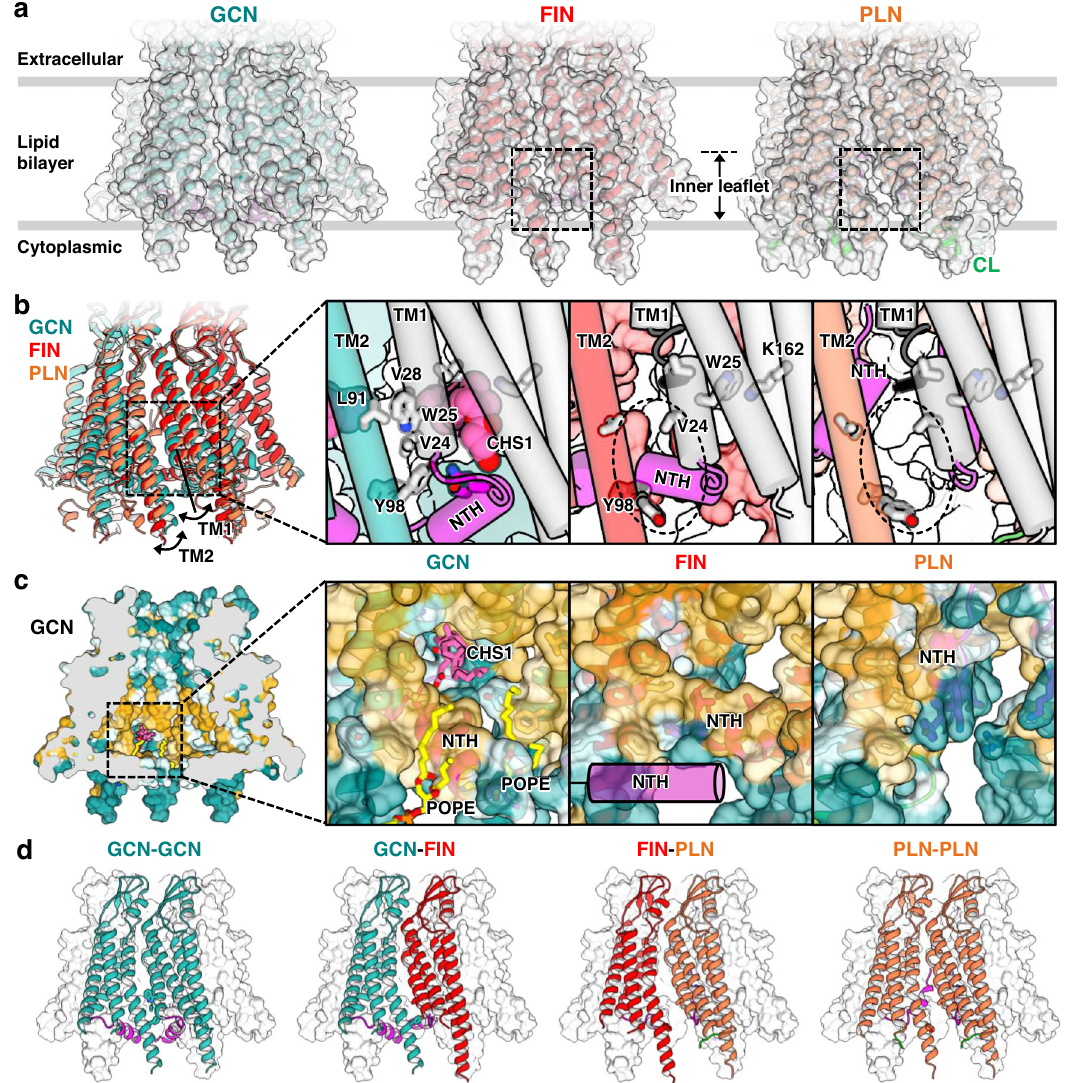
Fig. 6 | Membrane openings in the FIN and PLN hemichannel sub-structures. a Surface representations of the full GCN, FIN, and PLN hemichannel sub- structures. The membrane openings are shown in the FIN and PLN hemichannel sub-structures. b Structural alignment of the three hemichannel sub-structures in ( a )(left)andclose-upviewoftheboxedregionforeachhemichannelsub-structure (right). Helices and residues related to the membrane opening are drawn as cylinders and sticks, respectively. The membrane openings are indicated by the dottedcircles. c SlicedviewofCx43hemichannelsub-structuresin( a ),viewedfrom